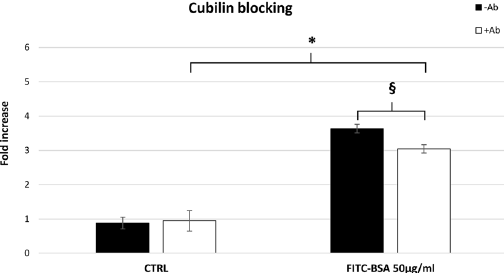
Figure 5. Cubilin is involved in albumin uptake. Antibody-mediated inhibition of cubilin (white blocks) led to a significant decrease in albumin endocytosis, indicating an involvement of this receptor in the protein uptake process in mature podocytes. Data are shown as the average ± SD of two different experiments in triplicate. CTRL: control cells. * P < 0.05, § P <